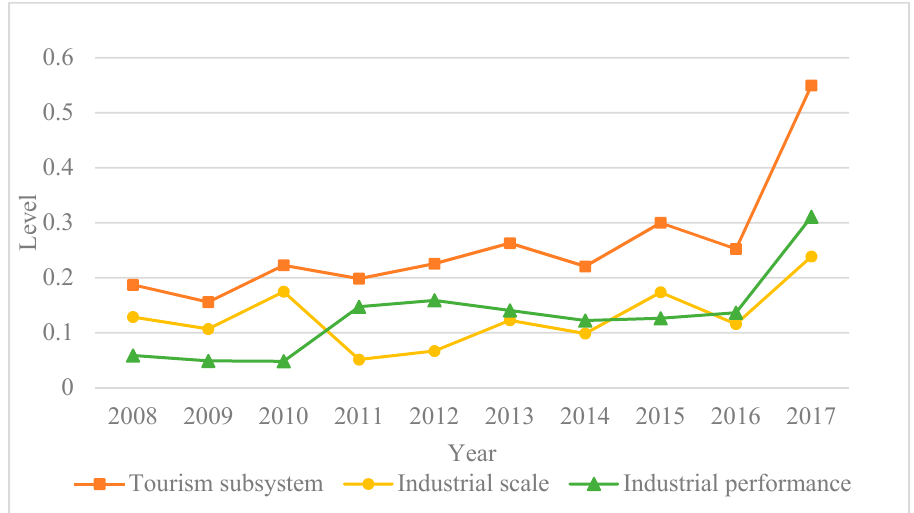
Figure 3. Comprehensive tourism subsystems.